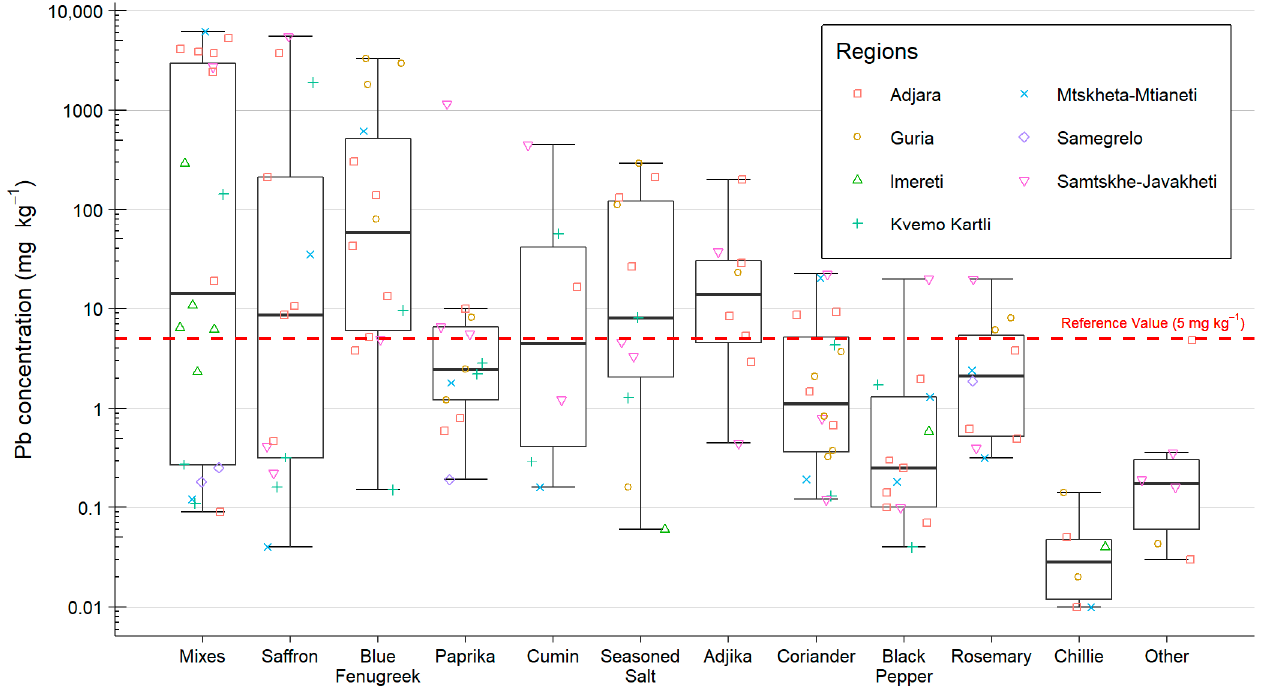
Figure 4. Box and whisker plot of the Pb concentration for each spice category analysed in this study. The plot shows the mean, median, and interquartile range of the data, and any outlier samples. The